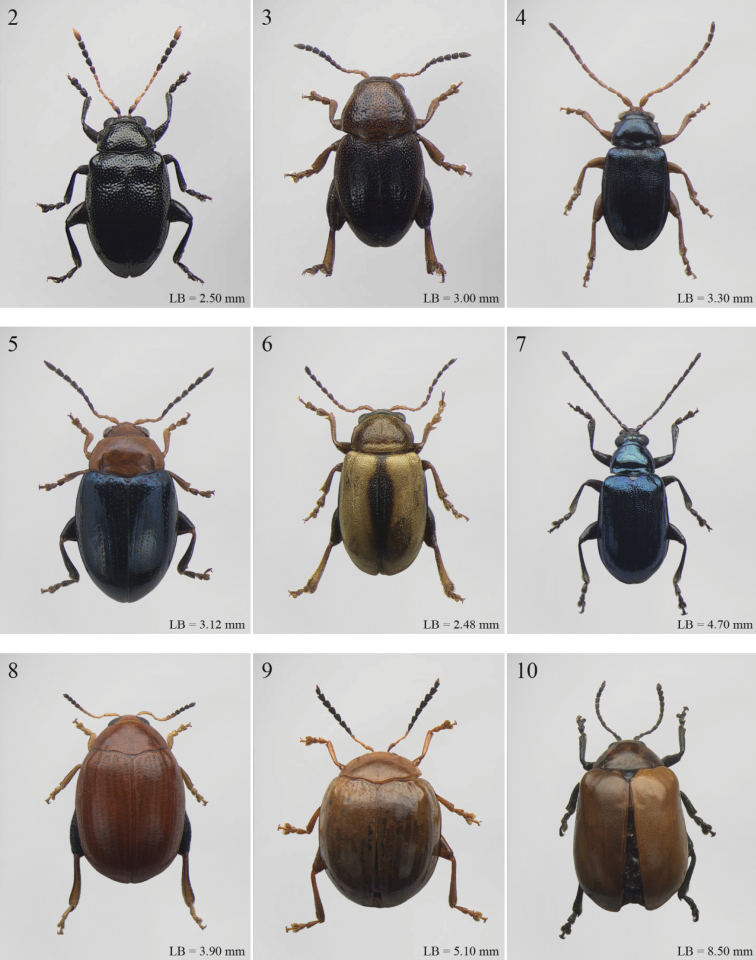
Habitus. 2
Abrarius cribrosus Fairmaire 3
Afroaltica subaptera Biondi & D’Alessandro 4 Afrocrepis malvernensis (Jacoby) 5
Afrorestia peringueyi (Jacoby) 6
Alocypha bimaculata (Jacoby) 7
Altica madagascariensis (Allard) 8
Amphimela bryanti (Csiki) 9
Amphimela (ex Sphaerophysa Baly) heikertingeri (Bechyné) 10
Anaxerta castanea Fairmaire.